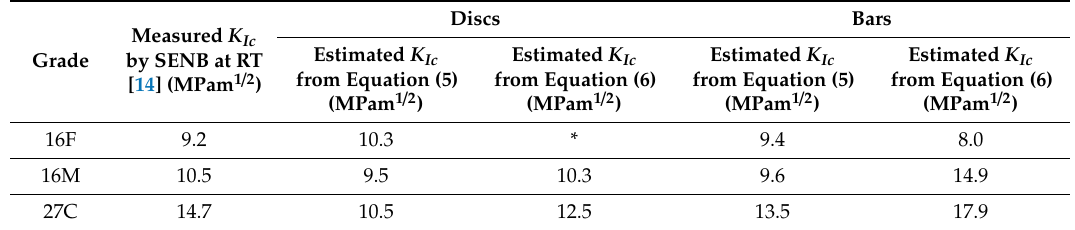
Table 3. Fracture toughness estimated from the fracture surface area (Equation (5)) and the critical defect size (Equation (6)) for three cemented carbide grades compared with experimental results obtained by single edge notched bend